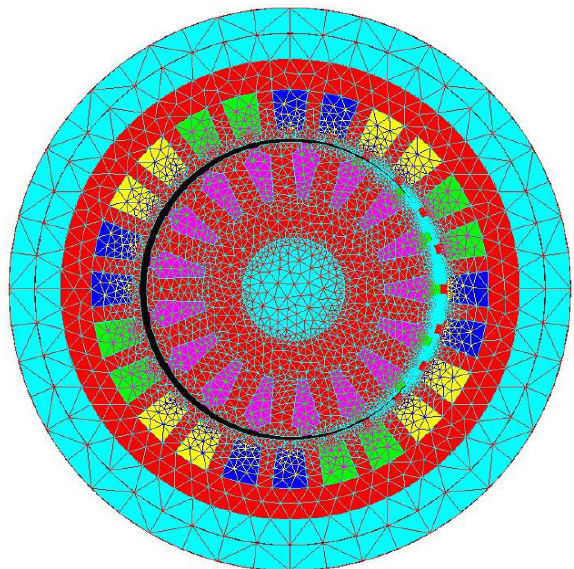
Figure 7. Mesh of an analyzed ZAIM.